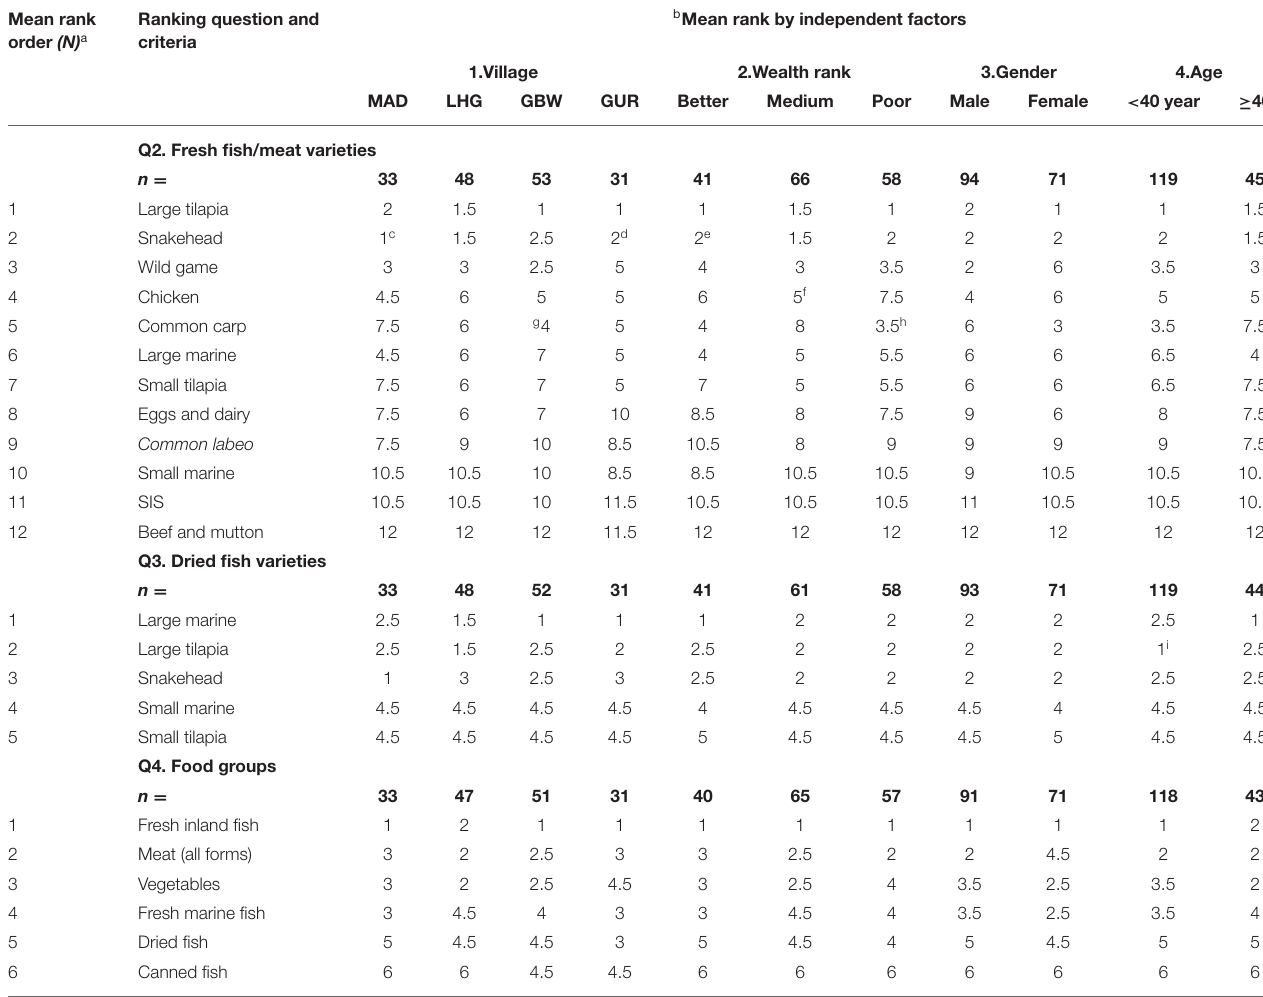
TABLE 8 | Overall ranks from pair-wise tests on preference ranks by independent factors: “village,” “wealth,” “Gender” and “Age” for questions 2, 3 and 4. Mean rank Ranking question and order (N) a